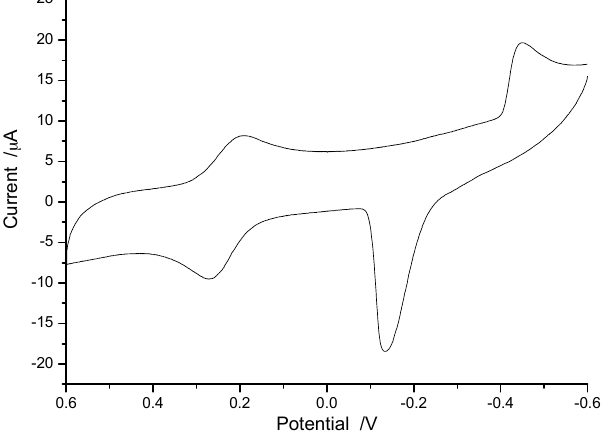
Figure 5. CV of 5.0 mmol/L Cu(II) in 0.1 mol/L HCl and 1.0 mol/L KCl, scan rate: 100 mV·s − 1 .